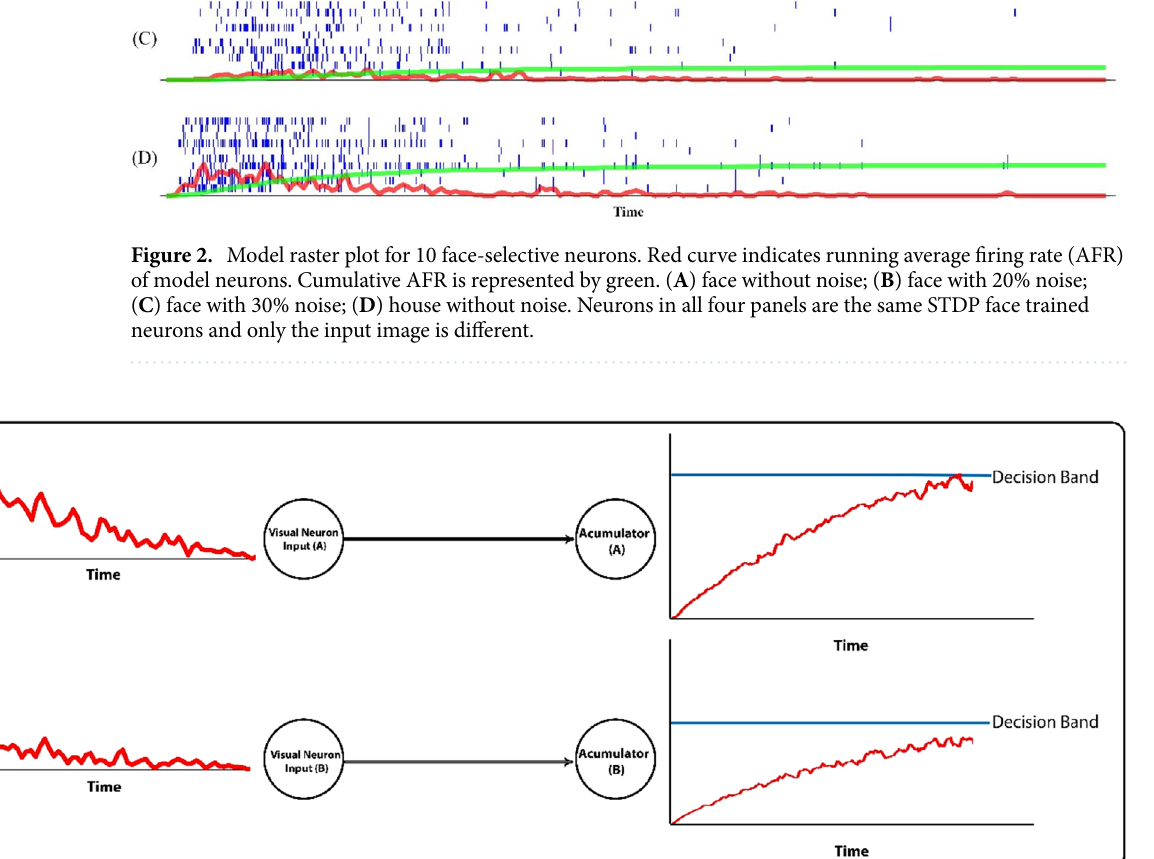
Figure 3. The schematic of accumulators in decision-making layer. Spikes generated by face and house selective neurons in the visual pathway model are entered to the corresponding accumulator. Spikes are integrated over time until they reach the threshold, and then the decision is made. The accumulator that reaches faster to the threshold identifies the class of input image. Decision time is calculated from the start of information accumulation until reaching the